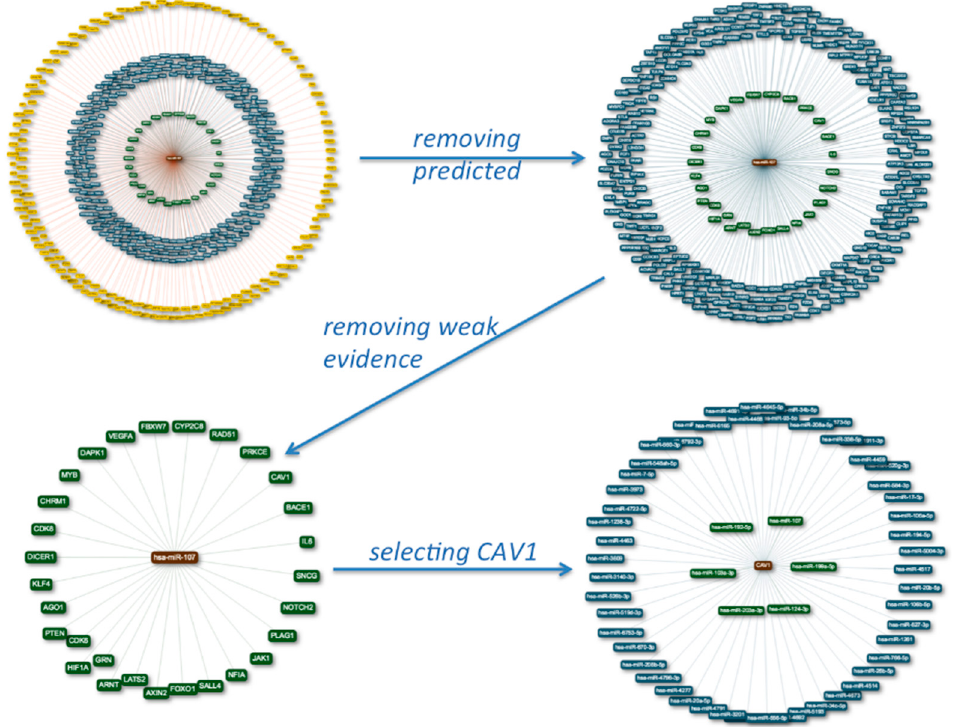
Figure 1. Single miRNA mode for miR-107: The central node is the miRNA, surrounded by validated targets with strong evidence (green), weak evidence (blue), and predicted targets (yellow). In the second representation predicted edges and in the third weak evidence edges are removed. The final representation is gene-centric for one of the target gens of miR-107, CAV1 .